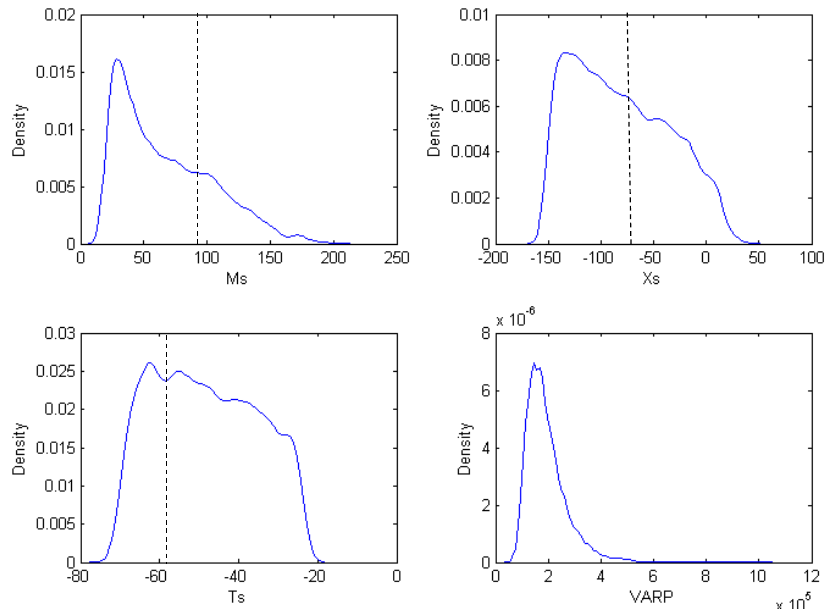
Figure 5. Posterior probability density functions with assumptions of homoscedastic errors (Run 1) Dashed lines denote the real values.